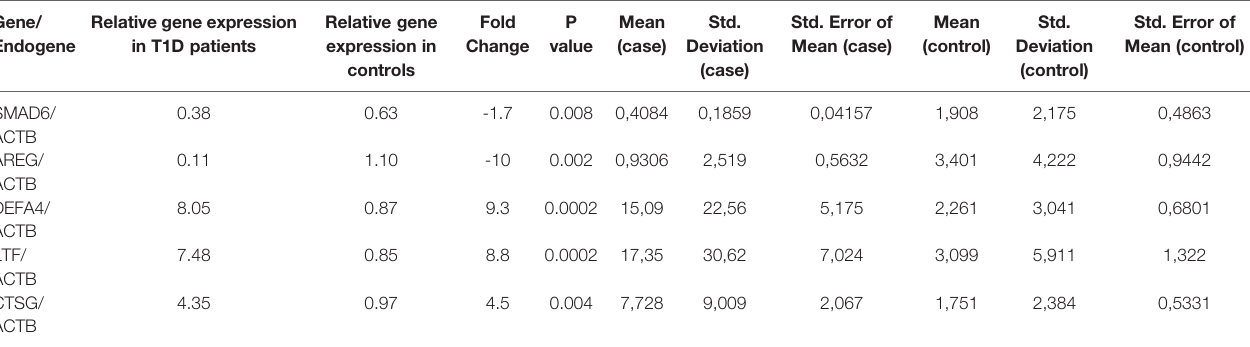
TABLE 3 | Gene expression validated by qRT-PCR. Gene/ Endogene